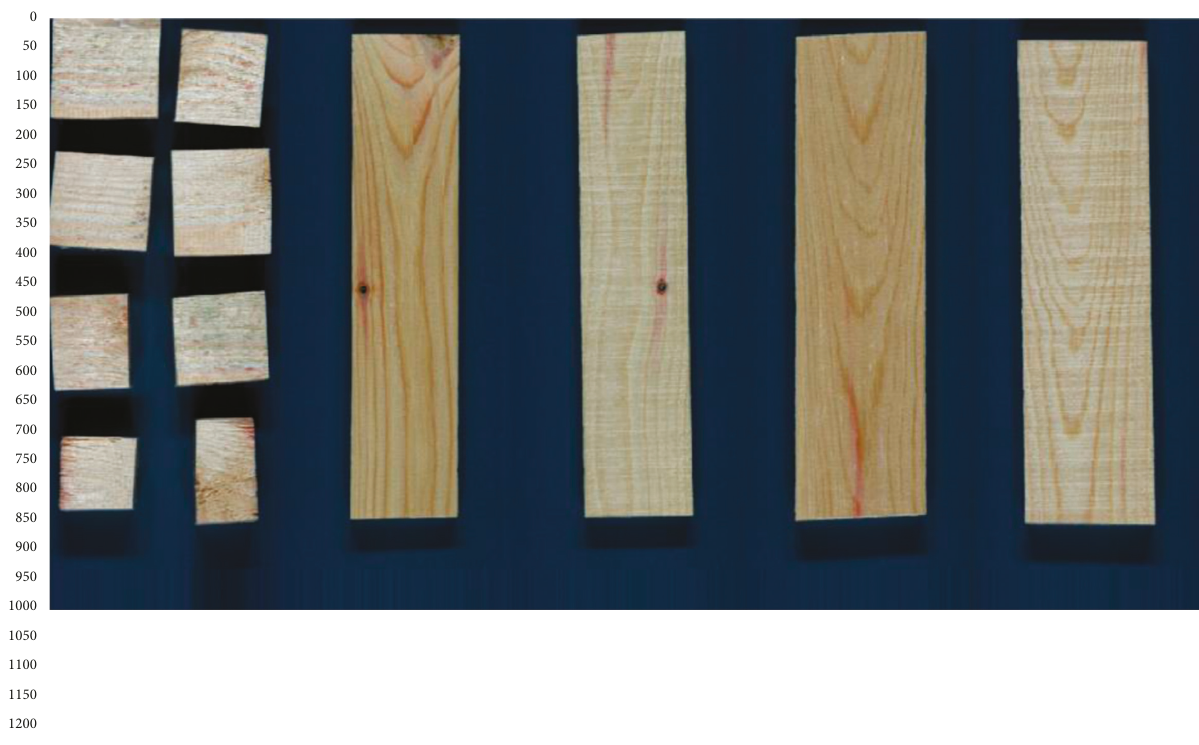
Figure 3: Merged digital images of the specimens: (a) air-kiln dried, (b) ThermoD planed surface, (c) ThermoD rip-cut surface, (d) WTT planed surface, and (e) WTT rip-cut